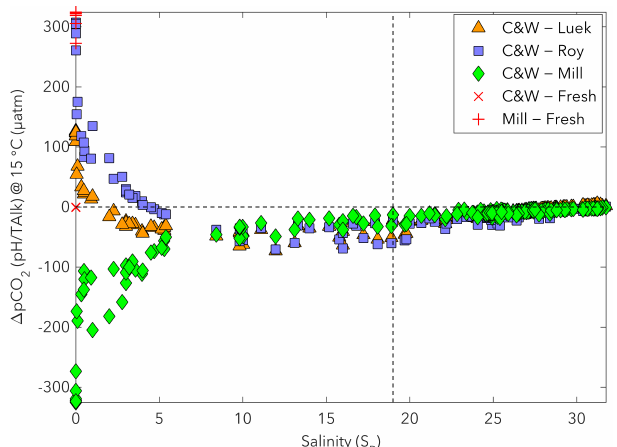
Figure 3. Differences in p CO 2 ( (cid:49)p CO 2 ) calculated using dif- ferent published formulations of K 1 and K 2 , including Cai and Wang (1998) (C&W), Lueker et al. (2000) (Luek), Roy et al. (1993) (Roy), Millero (2010) (Mill), and Millero (1979) for pure water only ( S P = 0) (Fresh). All calculations were carried out at 15 ◦ C ( p CO 2 at 15 ◦ C) with measured pH and TAlk. The constants of Lueker et al. (2000) are recommended for best practices by Dickson et al. (2007) and are applicable for waters at S P > 19 (delineated by the vertical dashed line), whereas those of Roy et al. (1993) ( S P = 5 to 45) are recommended by Dickson and Goyet (1994). Both the constants of Cai and Wang (1998) and Millero (2010) have been proposed as more appropriate for the study of the carbonate system in estuarine